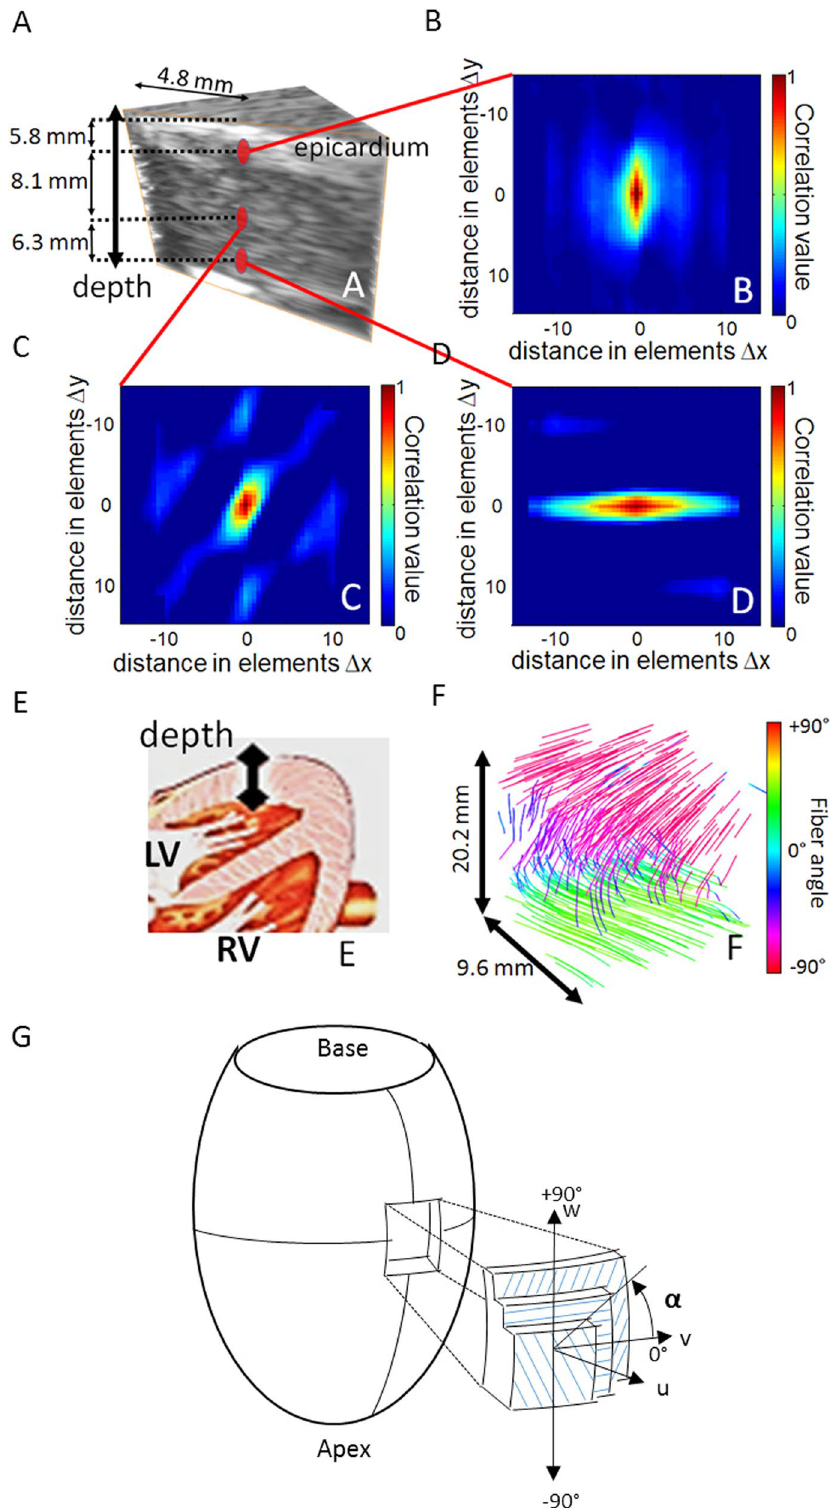
Figure 2. 3D-BTI of one ex vivo porcine myocardial sample. ( A ) 3D grayscale ultrasound image of one myocardial sample. ( B , C , D ) Three examples of spatial coherence functions obtained for different depth locations in the sample. ( E ) Drawing of the heart associated to the ultrasound acquisition location. ( F ) Vector representation used for the visualization of the transmural variation of the fibers in the entire sample. ( G ) Schematic representation of the reference coordinates. Local axes u, v and w are defined by the circumferential and longitudinal directions on the epicardial surface. Fiber angle α , is positive when measured counterclockwise from the v-axis. (Figure adapted from Streeter et al . 27